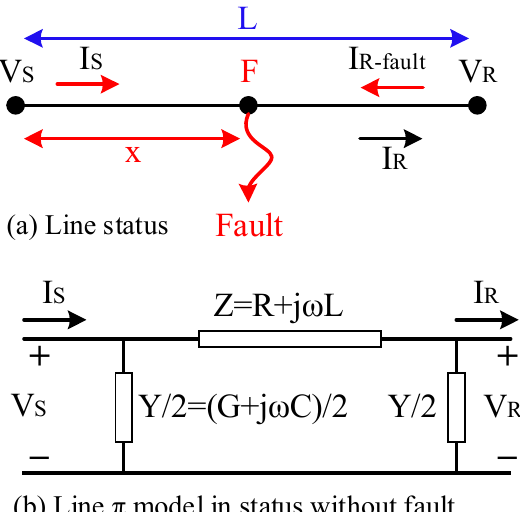
Figure 7. Information of a sample